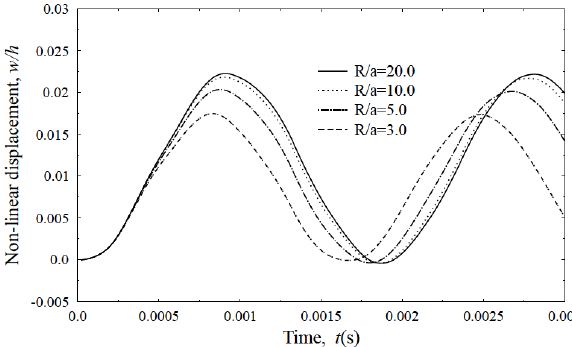
Figure 7: Nonlinear transient displacements ( w / h ) of SWCNT rein- forced composite spherical shells for different radius-length ratios ( q = 1.0 MPa, [0/90] s , V f = 0.8 , w cnt = 1.0% , no cutout)